Question: In a single sentence, describe what this figure presents.
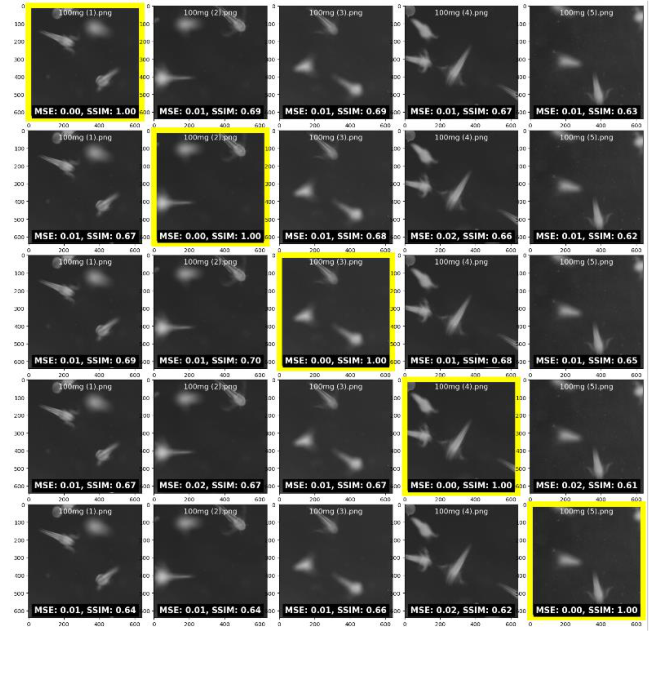
Answer: SSIM and MSE values of some sample of 100mg  concentration